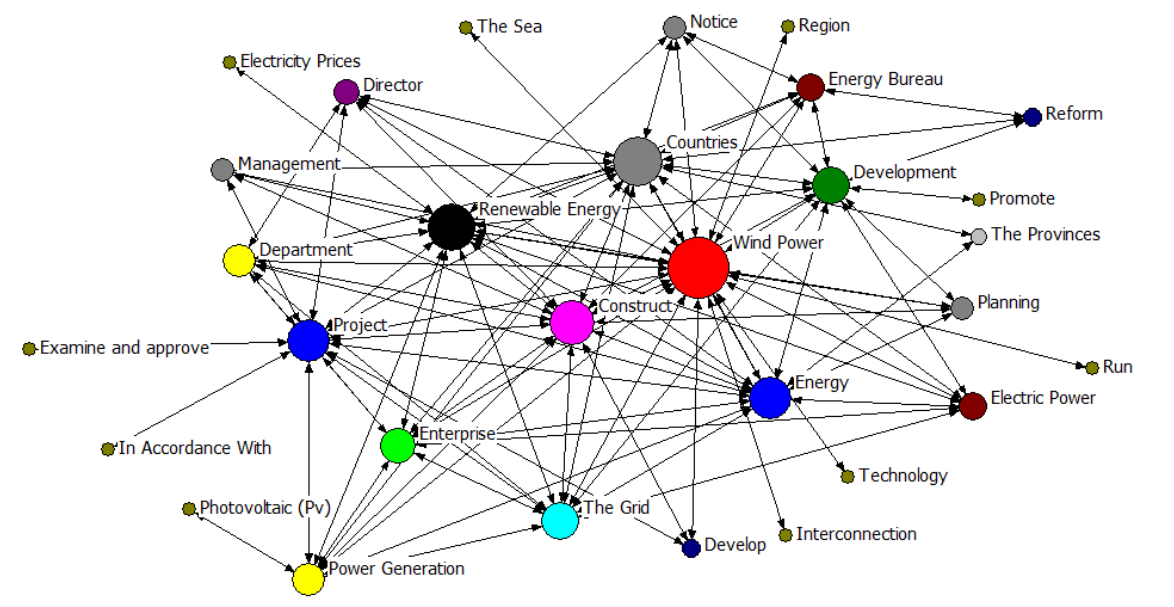
Figure 2. Semantic network diagram of wind power industry policy. Table 4. The centrality of the key words of the wind power industry policy.